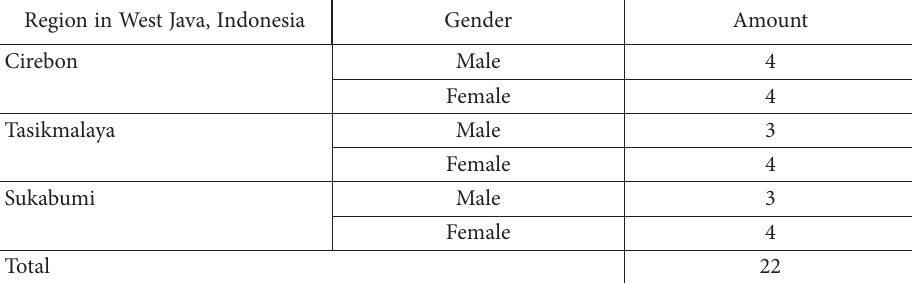
Table 1. Research participant (source: created by